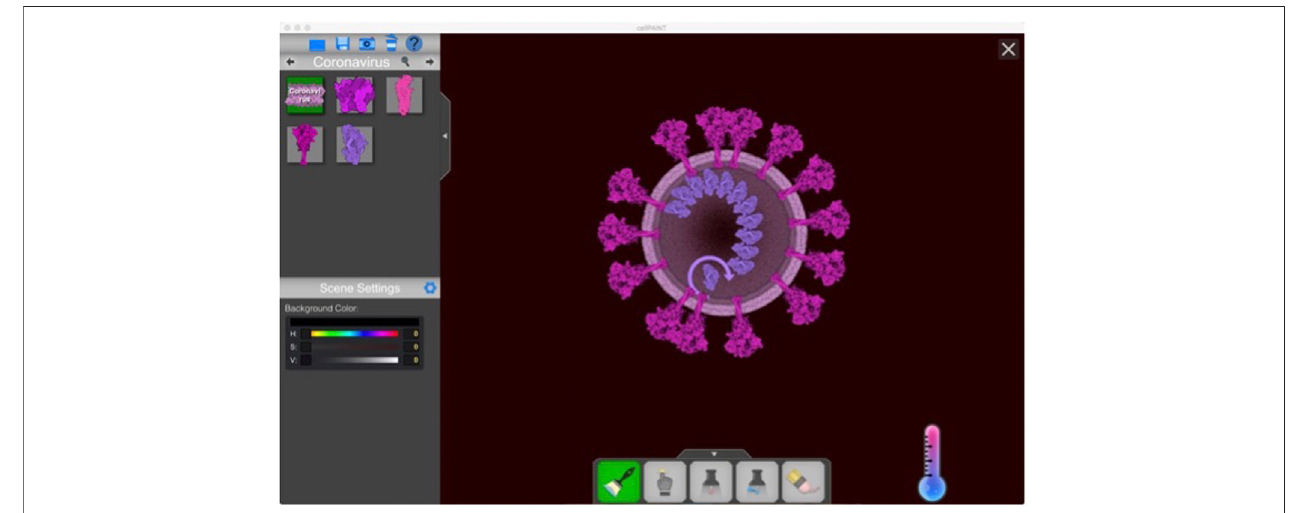
FIGURE 8 | CellPAINT-coronavirus (CellPAINT-Coronavirus,